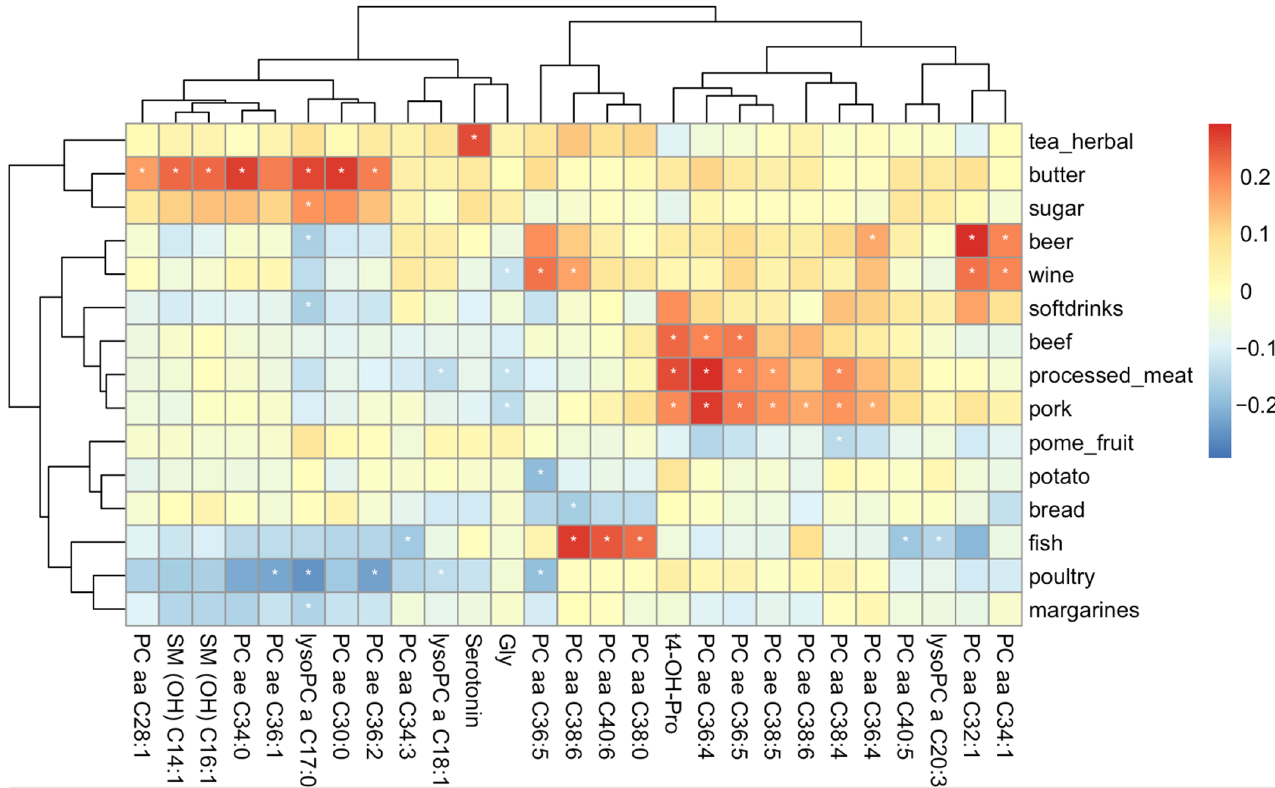
Figure 3. Heatmap of coefficients representing the difference in metabolite concentrations between the top and bottom 20% of individuals with the highest and lowest consumption of a food item. Only food items (rows) and metabolites (columns) are shown with at least one significant relationship. Significant coefficients are indicated with a white asterisk. Red coloring represents higher metabolite concentrations in participants with a higher consumption of the food items, blue coloring the opposite.